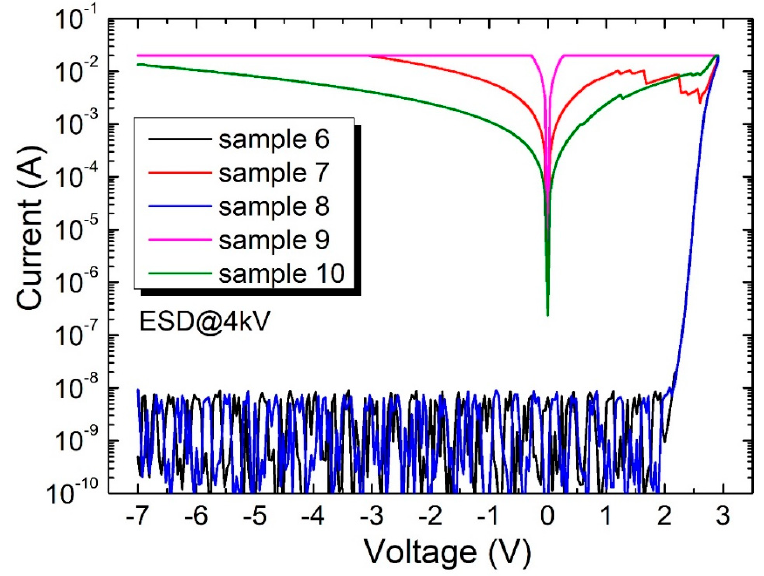
Figure 3. Current–voltage curves after an ESD bias of 4 kV. Three samples were failed, and two samples were